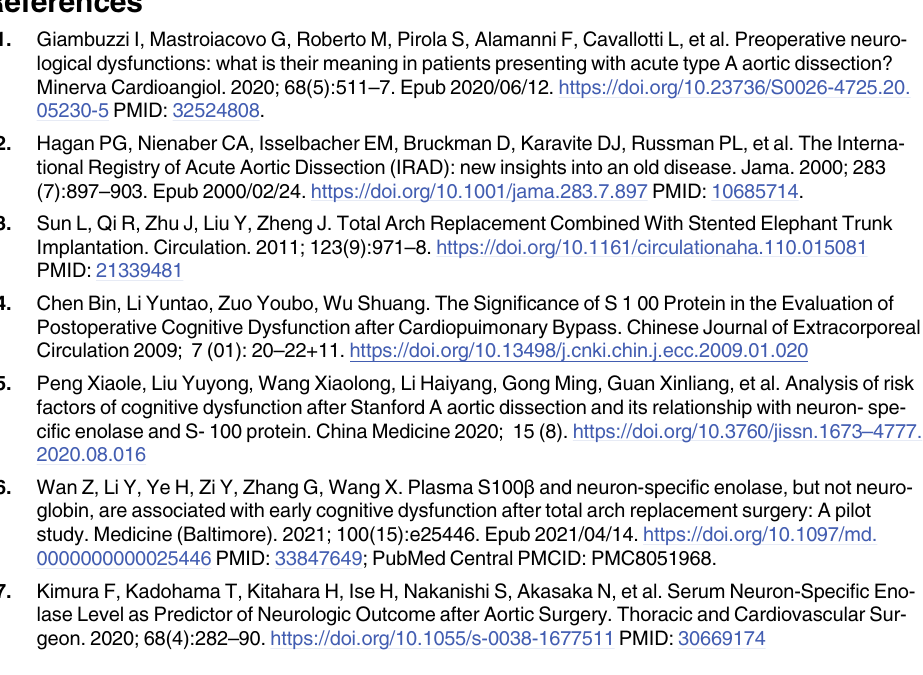
compensation method. (C) Funnel plot corrected by trim and filling method. (TIF) S2 Fig. S100B predicting neurological complications at 6 hours after operation. (A) Sensi- tivity analysis plot. (B) Funnel plot. (C) Analysis results after correction by trim and filling method. (D) Funnel plot corrected by trim and filling method. S3 Fig. Correction of S100B predicting neurological complications at 24 hours after opera- tion. (A) Sensitivity analysis plot before correction. (B) Funnel plot after sensitivity analysis. (C) Analysis results after correction by trim and filling method.(D) Funnel plot corrected by trim and filling method. S4 Fig. Correction of S100B predicting neurological complications at 6 and 24 hours after operation. (A) Sensitivity analysis plot before correction. (B) Funnel plot after sensitivity anal- ysis. (C) Analysis results after correction by trim and filling method. (D) Funnel plot corrected by trim and filling